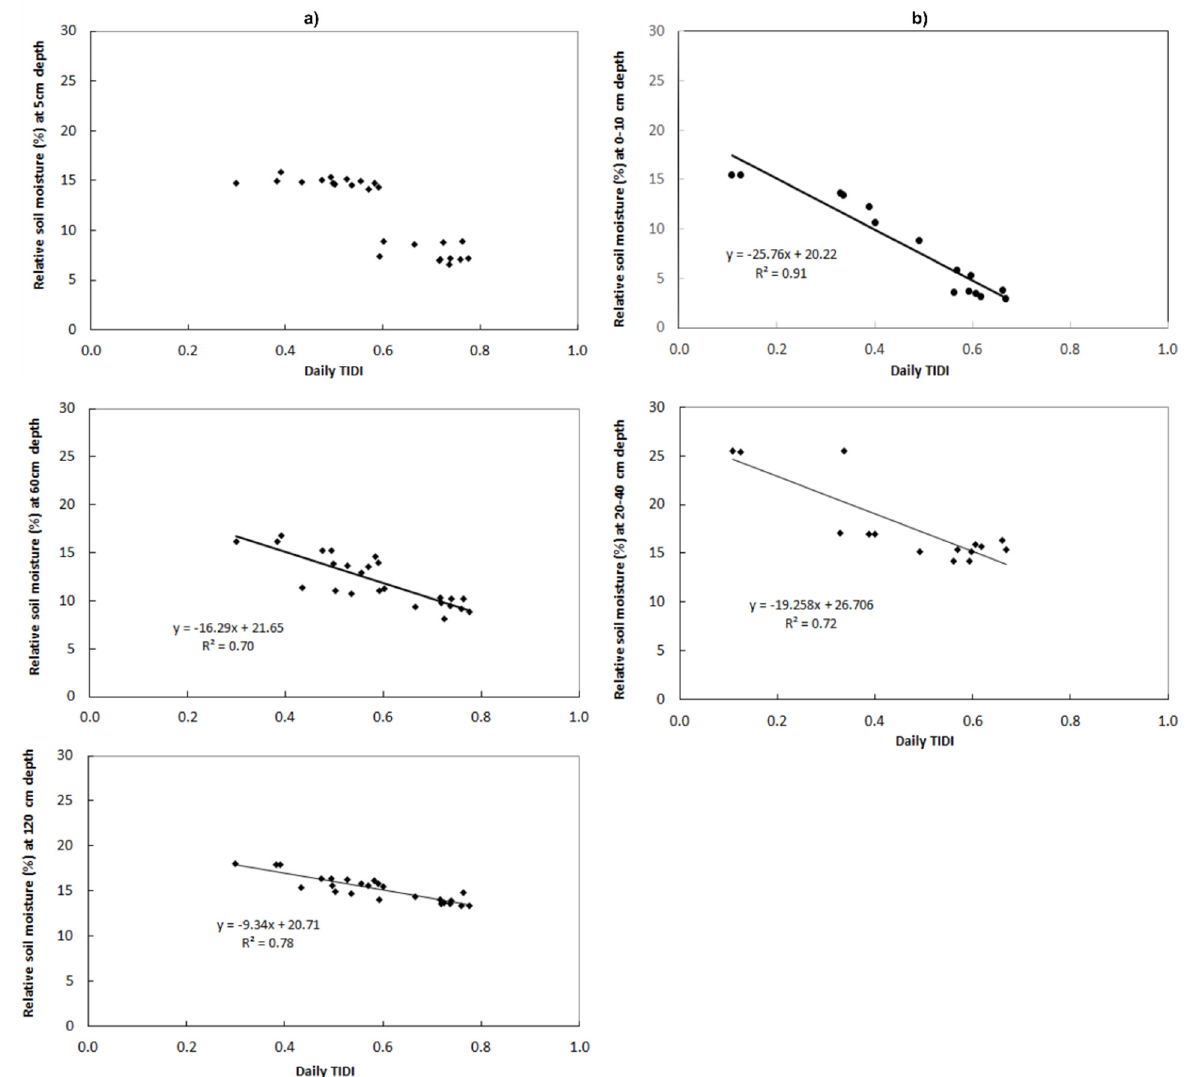
Figure 11. Relationship between daily TIDI and subsurface soil moisture in ( a ) La Ydalina station (N = 25, soil: Entic Hapludoll, sandy loam texture, depths of soil moisture measurements: 5 cm, 60 cm, 120 cm) and ( b ) Tandil station (N = 15, soil: Typic Argiudoll, silty loam texture in shallow horizons and silty clay texture in deeper horizons, depths of soil moisture measurements: 0–10 cm, 20–40 cm).